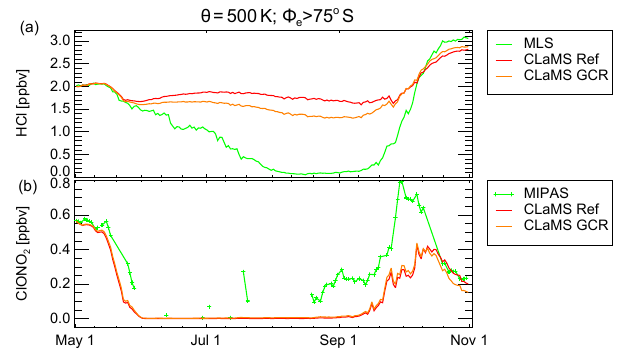
Figure 10. Average mixing ratios in the vortex core ( (cid:56) e > 75 ◦ S, θ = 500K) of HCl (a) and ClONO 2 (b) . Green lines show MLS and MIPAS observations, respectively. CLaMS results are shown for the reference simulation (red) and the simulation with incorpo- rated ionisation from galactic cosmic rays (GCRs,